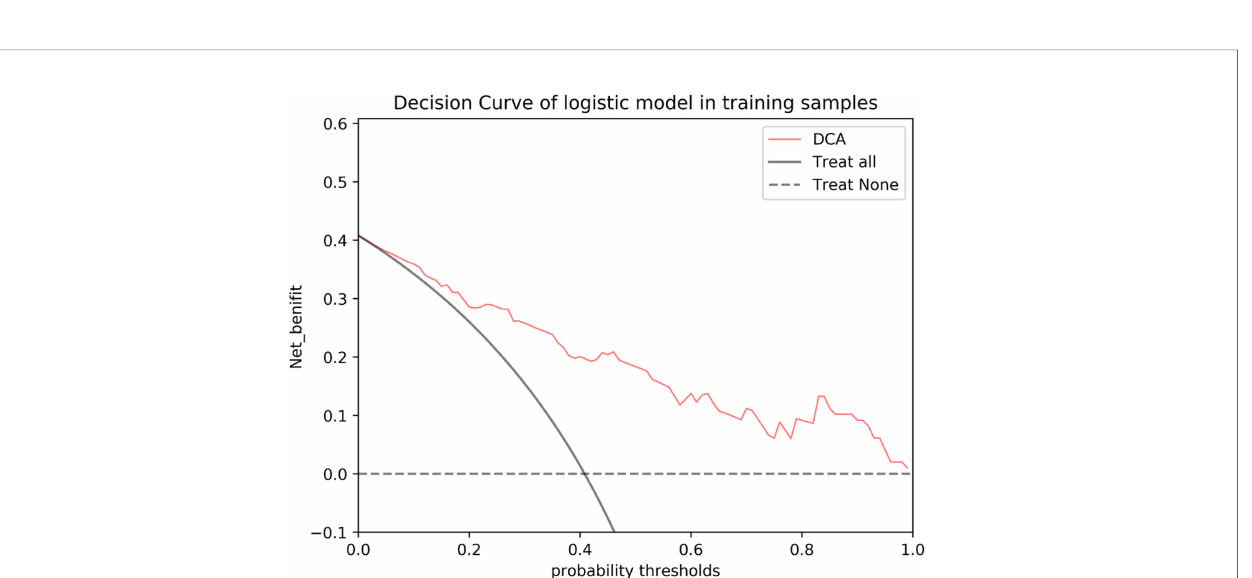
FIGURE 7 | DCA of the nomogram based on MRI-reported LN status and rad-score 3 in the validation cohort. The red line, gray line, and horizontal dotted line represent the net bene fi t of the nomogram, treat-all strategy, and treat-none strategy, respectively.